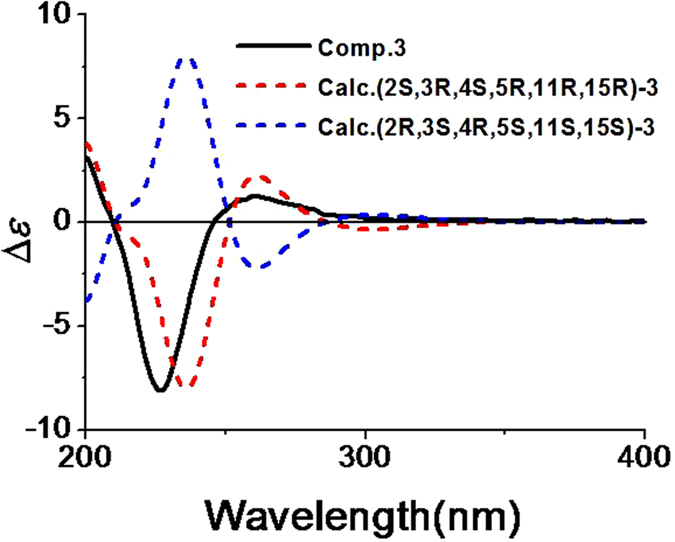
Experimental ECD spectra of 3 and calculated ECD spectra of (2S, 3R, 4S, 5R, 11R, 15R)-3 and (2R, 3S, 4R, 5S, 11S, 15S)-3.